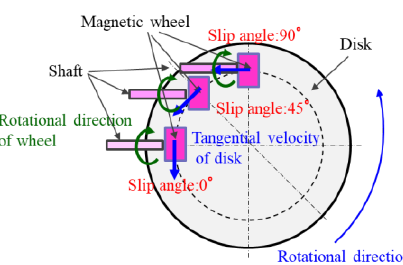
Figure 5. Arrangement of a magnetic wheel on a disk. When the slip angle was 0, the magnet wheel was installed so that the rotation direction of the magnet wheel and the tangential direction of the disk were in the same direction. When the slip angle was 90 degrees, the magnet wheel was installed so that the rotation direction of the magnet wheel and the tangential direction of the disk became 90 degrees.